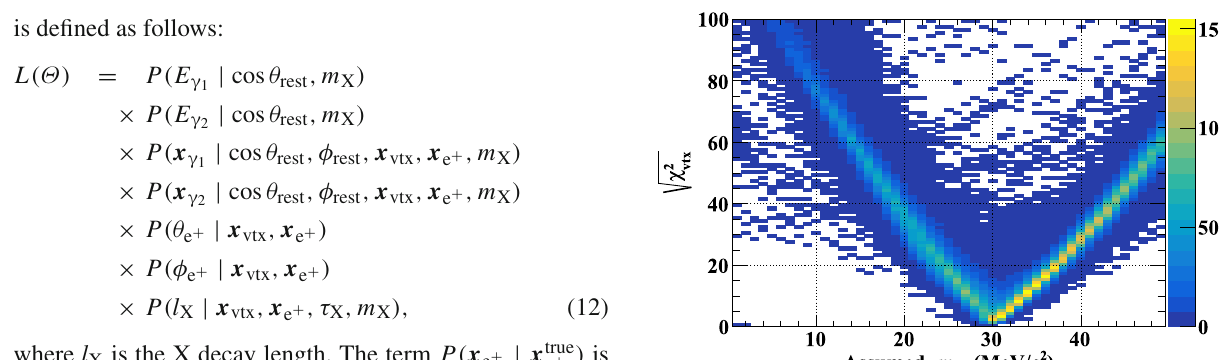
(cid:16) χ 2 Fig. 12 vtx distribution for the MC signal events at ( 30 MeV / c 2 , 20 ps ) as a function of m